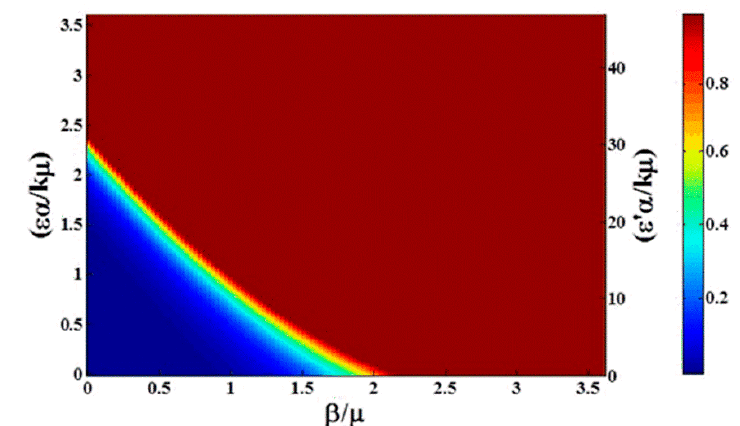
Figure 6. Heat map of the infectious fraction at t = 100 days including the effects of dose response with a power ν = 1.6, and Q 0 = 0.2. In general, for ν > 1, the epidemic is delayed but the transition from I = 0 to a fully infectious population is sharpened relative to direct transmission (or indirect transmission with ν = 1.0). Parameter values are β = [ 0, 12 ] , (cid:15) = [ 0, 12 ] , k = 1, α = 0.1, and µ = 1/30.